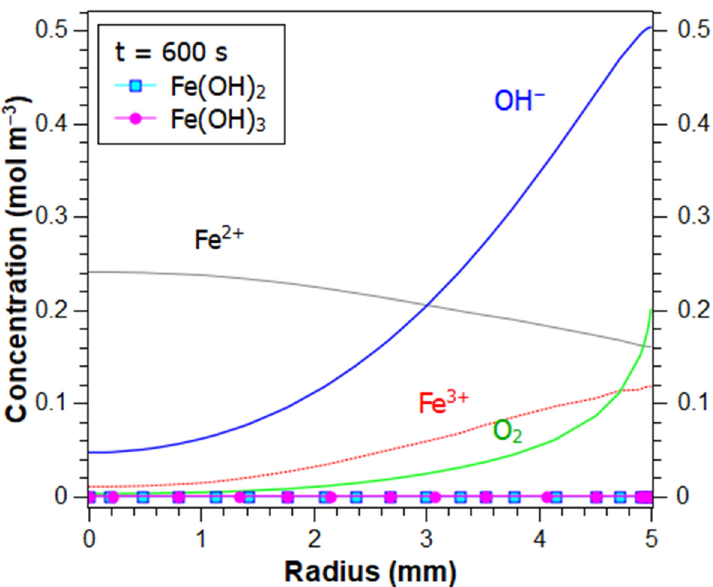
Figure 10. Concentration profiles of all species along the electrode surface for 600 s time .